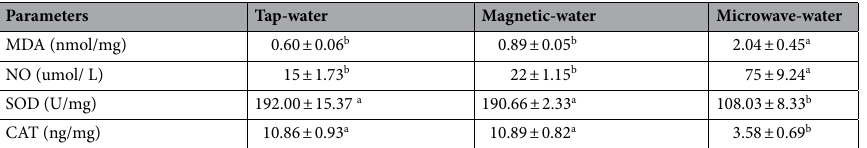
Table 2. Effect of magnetic- and microwave-water on superoxide dismutase, catalase and oxidative parameters in liver tissues of rats (mean ± SE). SOD (superoxide dismutase); CAT (catalase); MDA (malondialdehyde); and NO (nitric oxide). Values with different letters ( a and b ) in each column denote significant